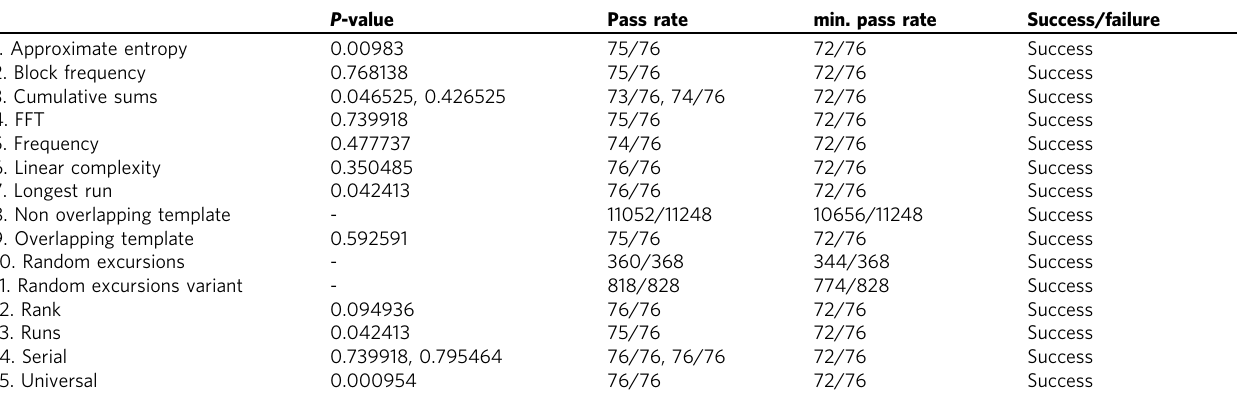
Table 1 Randomness test (NIST 800-22 test suite) results for a diffusive memristor true random number generator P -value Pass rate min. pass